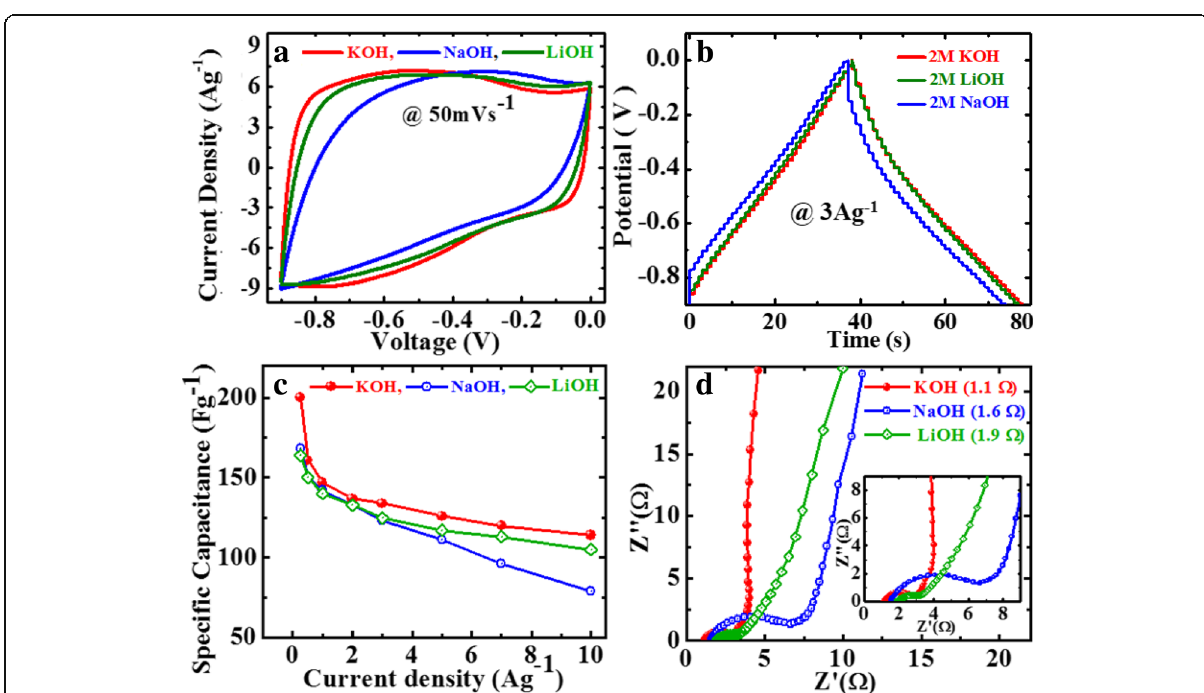
Fig. 6 Electrochemical performance of GP10C film in different aqueous KOH, LiOH, and NaOH in 2 M electrolytes, a CV curves at 50 mVs − 1 , b GCD curves at 3 Ag − 1 , c SC as calculated from GCD curves, and d Nyquist plot in various electrolytes with inset showing the magnified